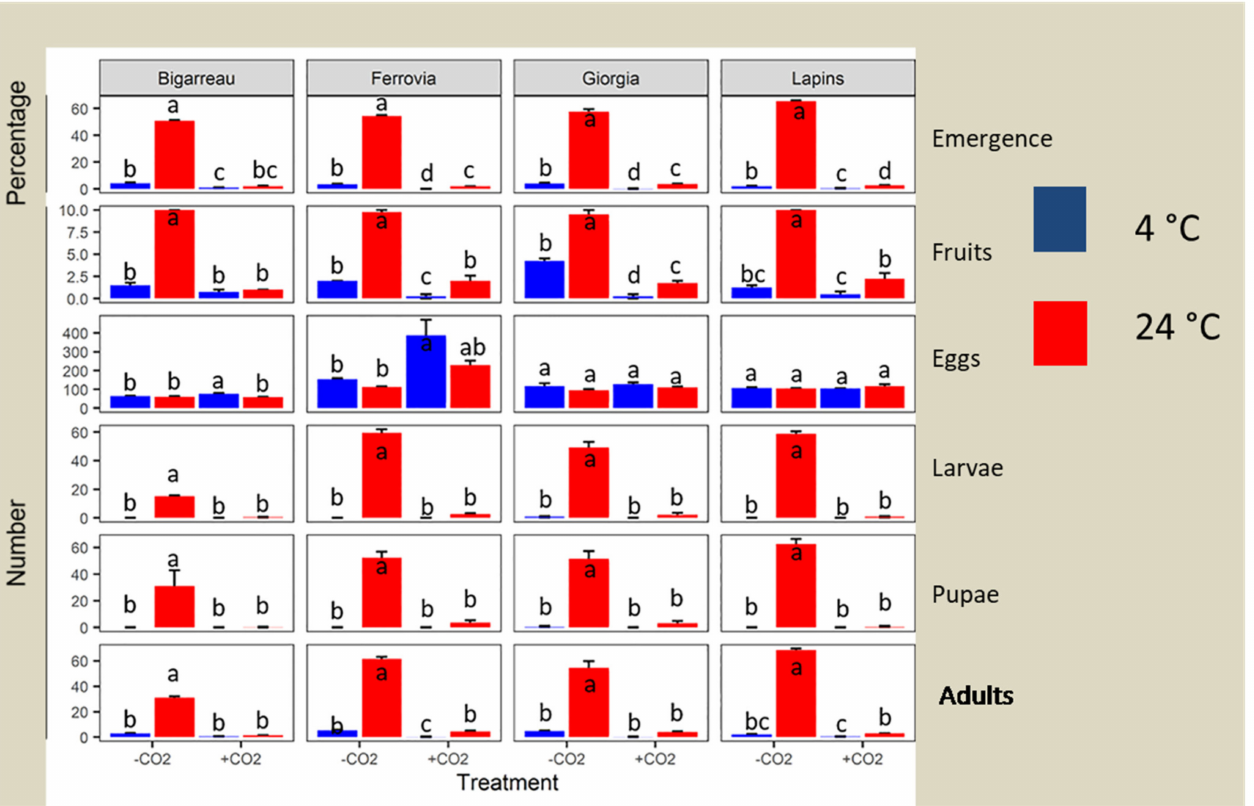
Figure 1. Several measurements of the insects, recorded on four cherry cultivars, treated or not with CO2, at 4 or 24 ◦ C. Within each graph, columns with different letters are significantly different according to contrasts ( p < 0.05). The number of fruits with emergence was analysed using a binomial model, while the number of eggs, larvae, pupae, and adults were analysed using negative binomial